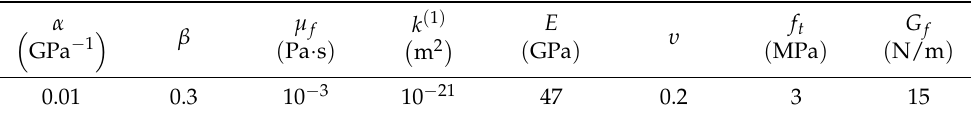
Table 1. Material parameters for the splitting test simulation.